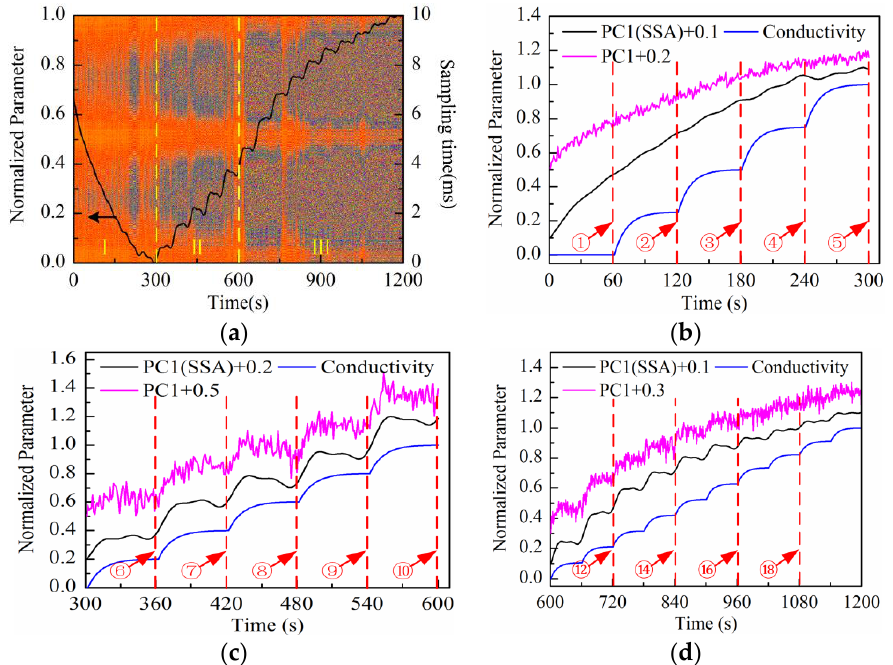
Figure 8. Measurement results of KCl solution conductivity variation process conducted with Au-IDT: ( a ) PC1 loading curve (after SSA) and the reconstructed noise image of the measurement period (0–20 min); ( b ) PC1 loading curve (before and after SSA) and theoretical conductivity variation curve of the first stage (0–5 min); ( c ) PC1 loading curve (before and after SSA) and theoretical conductivity variation curve of the second stage (5–10 min); ( d ) PC1 loading curve (before and after SSA) and theoretical conductivity variation curve of the third stage (10–20 min).